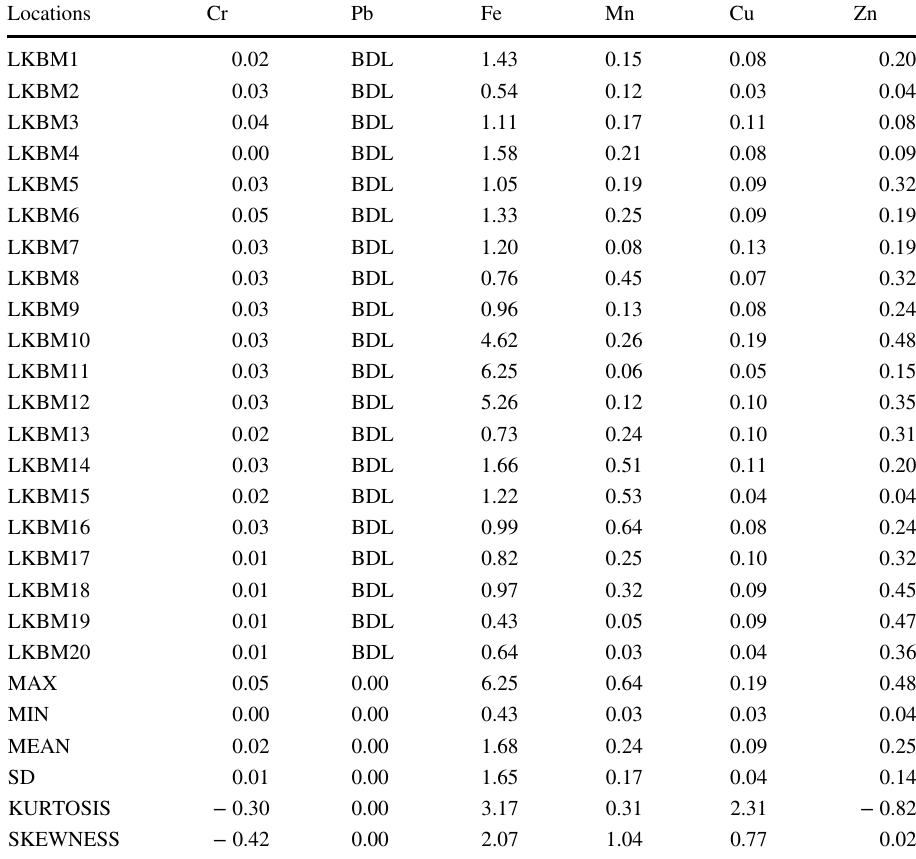
heavy metals in pre-monsoon season at North Guwahati